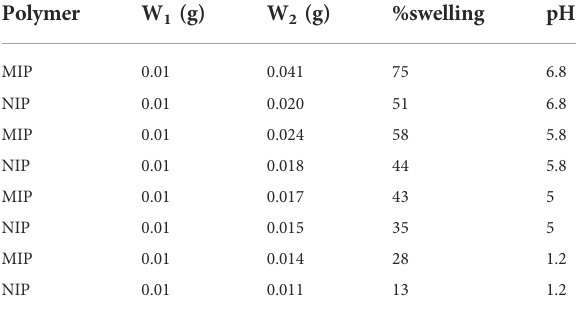
TABLE 1 Swelling amounts of MIPs and NIPs by